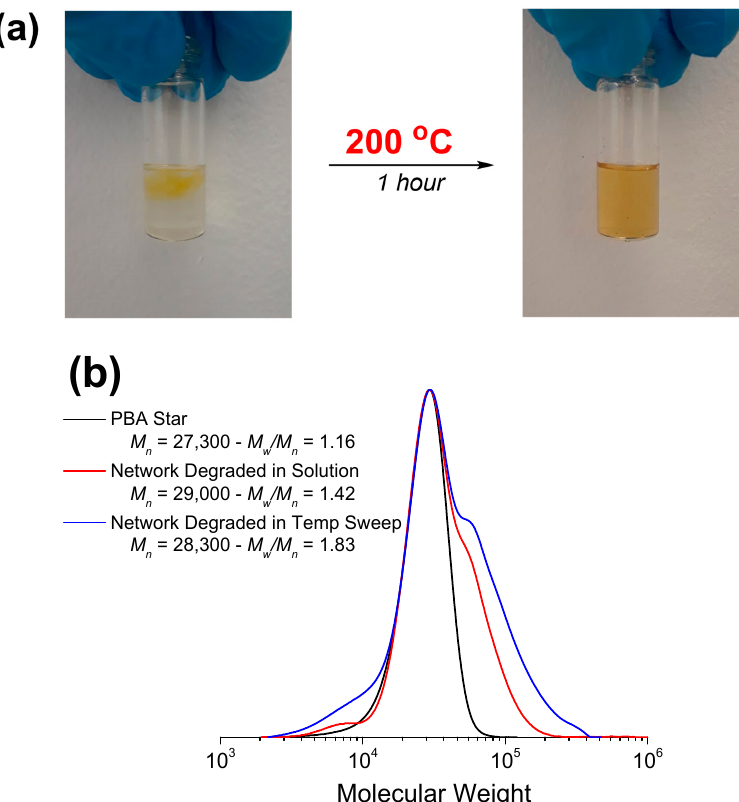
Figure 6. ( a ) The crosslinked network was swollen in 1,2,4-trichlorobenzene (40 mg sample/2 mL solvent) and heated at 200 °C for 60 min. ( b ) The GPC of PBA star polymer precursor and soluble components after degradation.